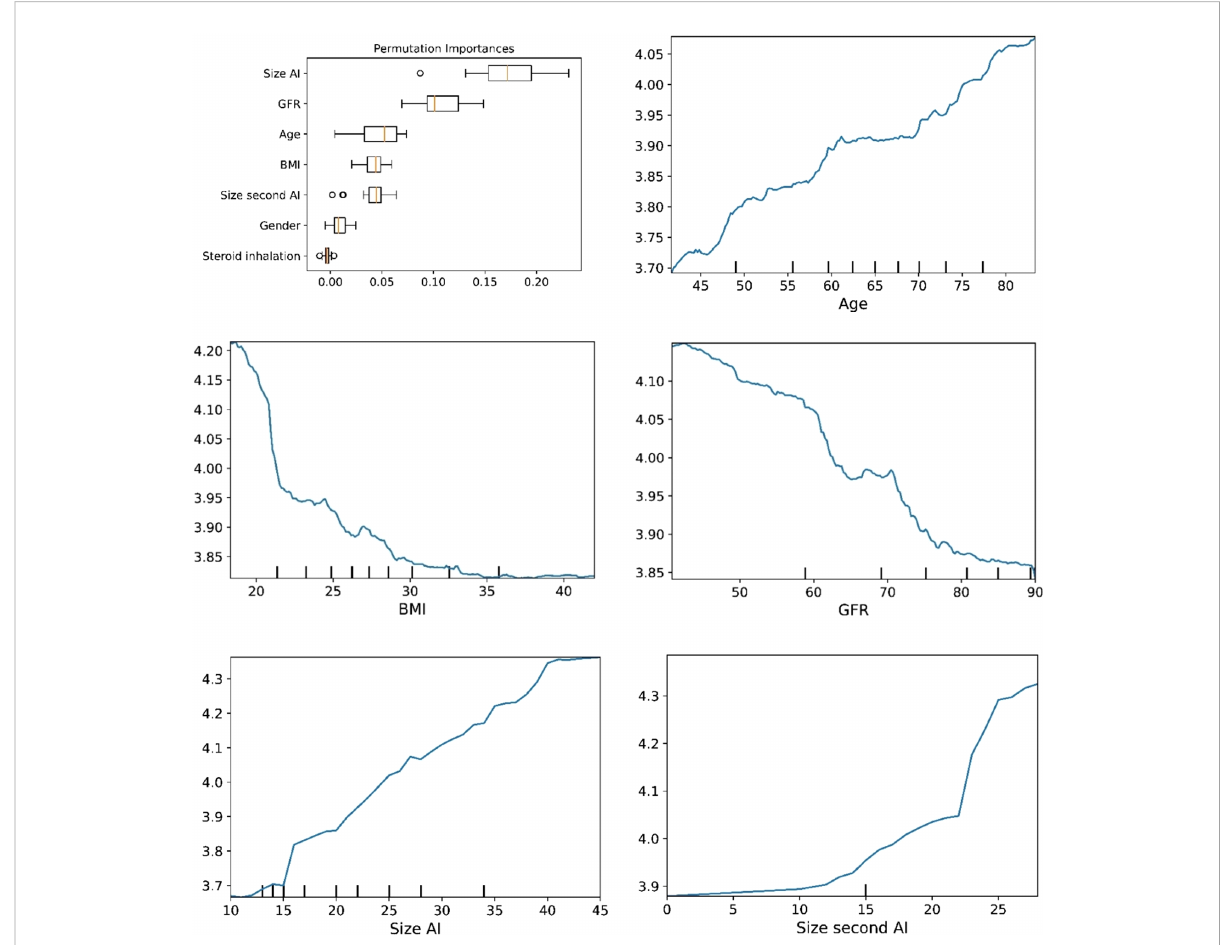
FIGURE 6 The plots for permutation importance and ln-transformed cortisol DST against age, BMI, eGFR, size of AI (in bilateral AI, the size of the largest AI), and size of the second AI using the ML model random forest. Figures 1 – 6 The fi gures give the found association to the studied variates at their levels between the 2nd and 98th percentiles. Random forests and gradient boosting presented a reasonable “ smoothening ” of the curve, and the slope of the curves resembled the slope of the curves from most of the other models. The slope for the relations between ln-transformed cortisol DST to age, BMI, and eGFR were relatively similar in the models. However, AdaBoost found a weaker association between ln-transformed cortisol DST and age and eGFR compared to the other six